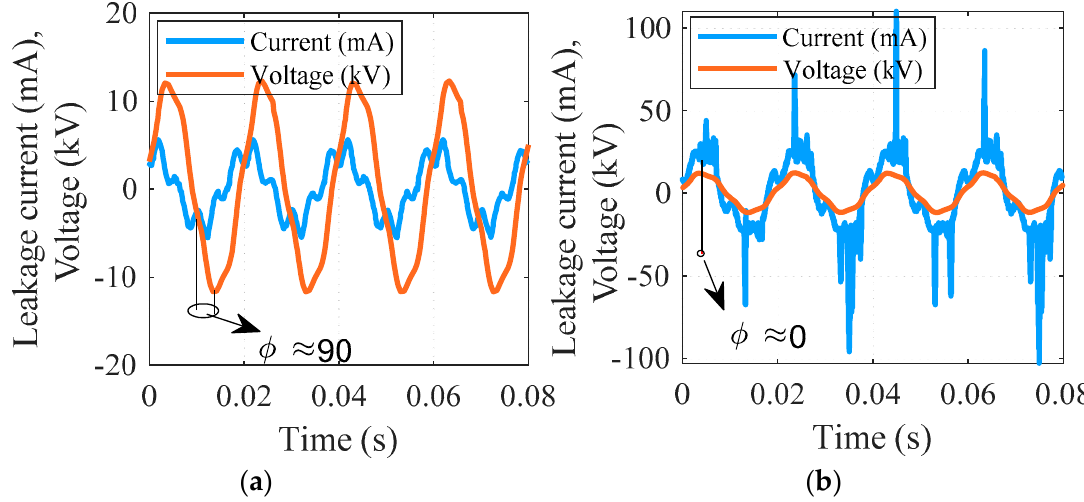
Figure 3. Leakage current and applied voltage phase angle: ( a ) clean; ( b ) pollution.